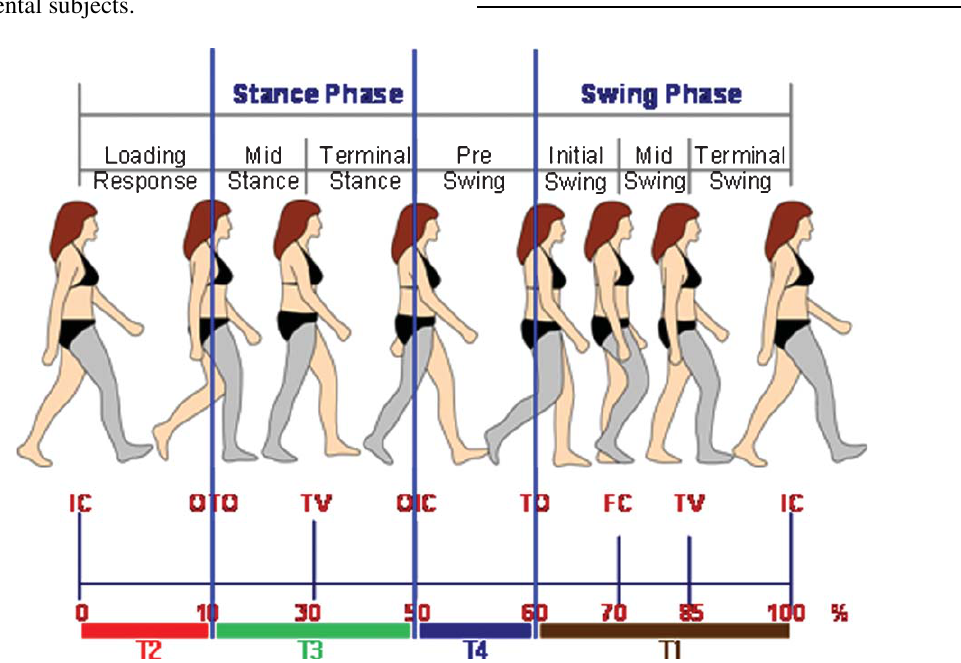
Fig. 6. Actuator control